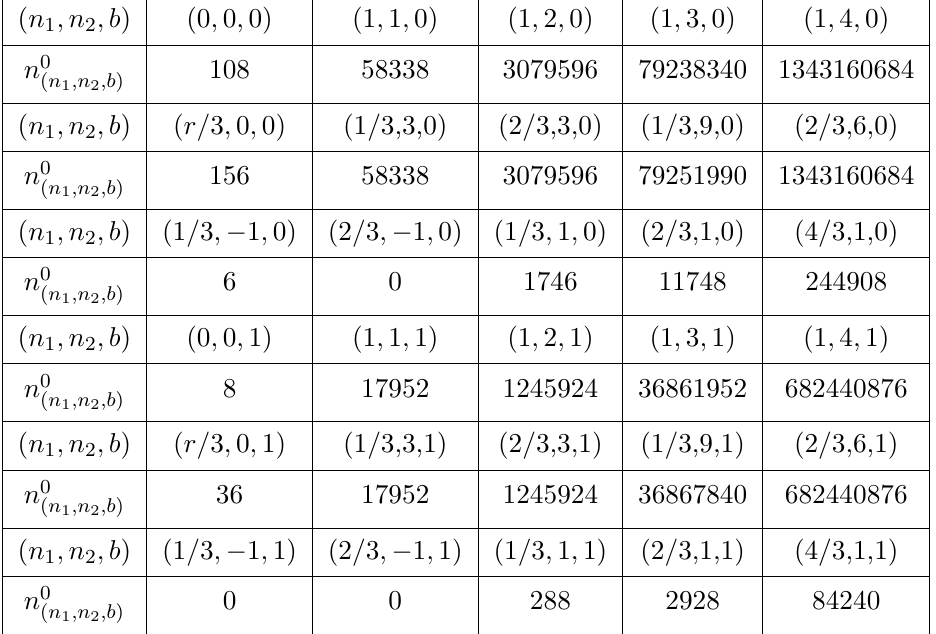
Table 16 . 3 A orbifold, non-standard embedding with single Wilson line. Shift is given by, (cid:13) = f 2 ; 0 7 g ; ~ (cid:13) = f 2 ; 0 7 g .